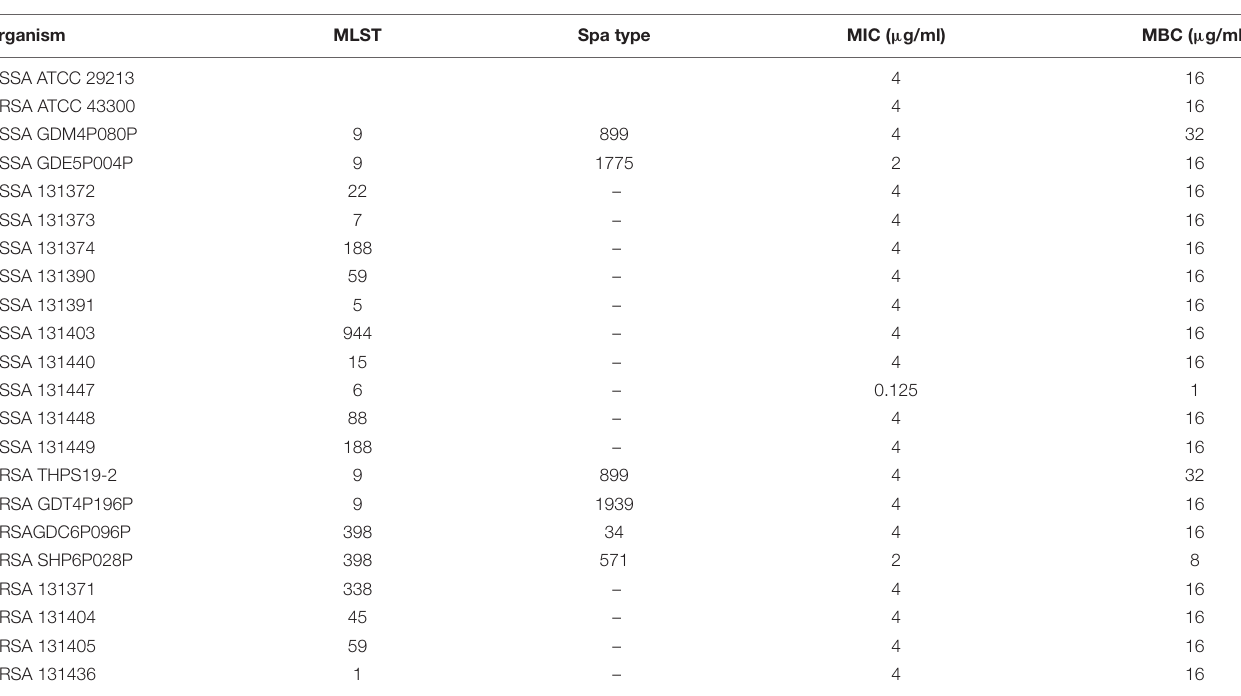
TABLE 2 | MBC of IBG against Staphylococcus aureus